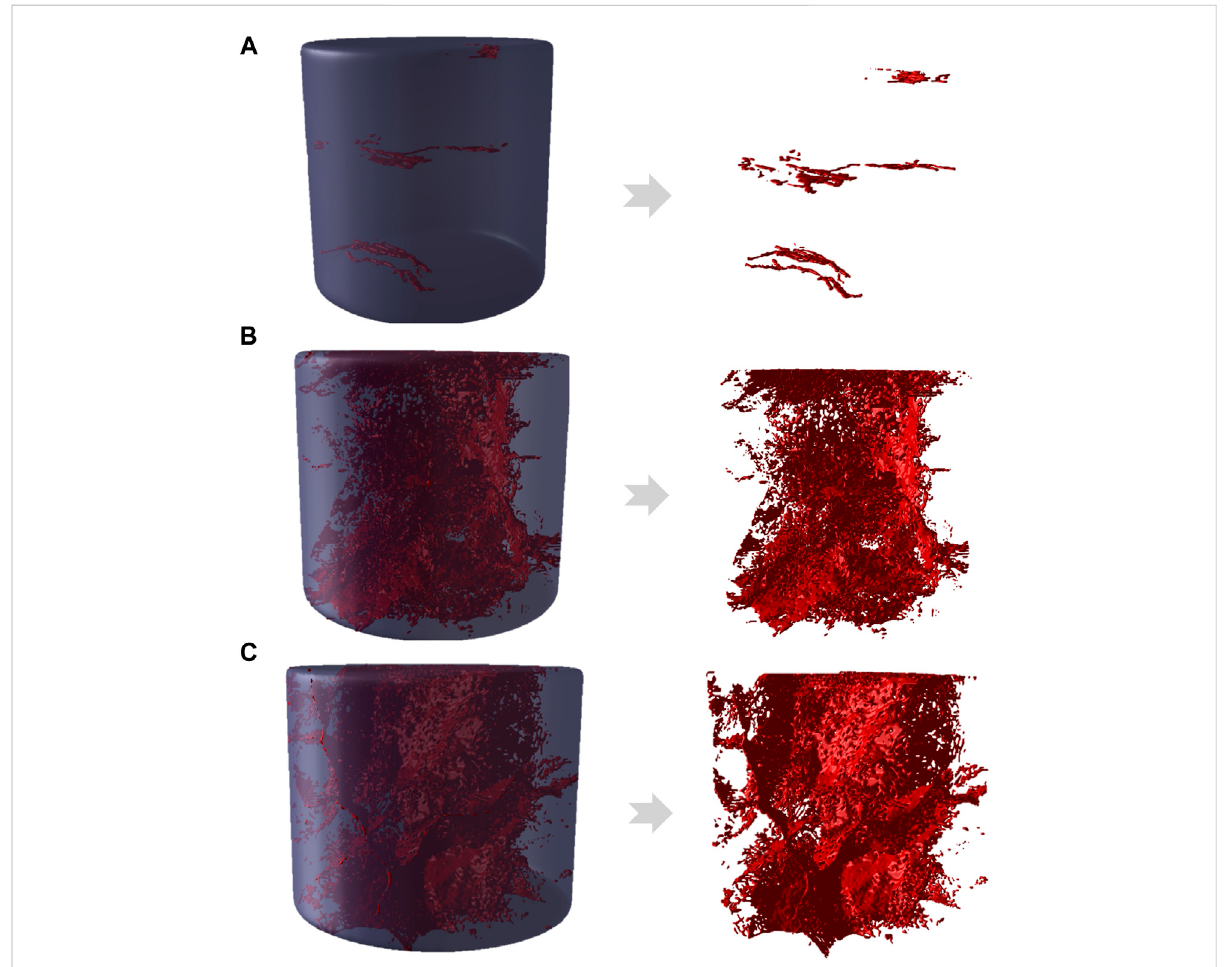
Three-dimensional pore model. (A) Undisturbed sample; (B) After one cycle; and (C) After two